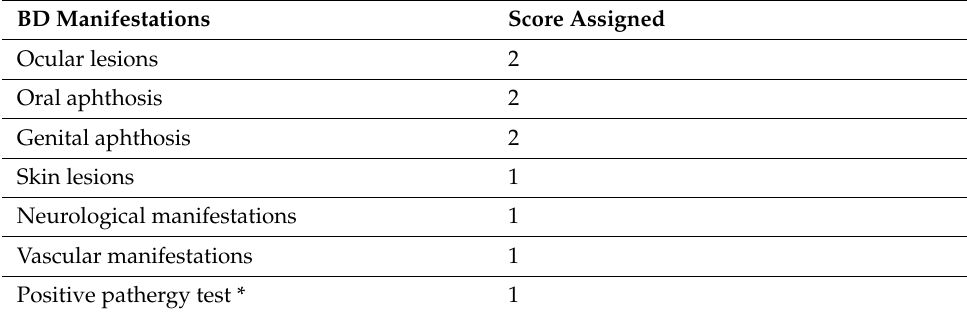
Table 4. International criteria for Behçet’s